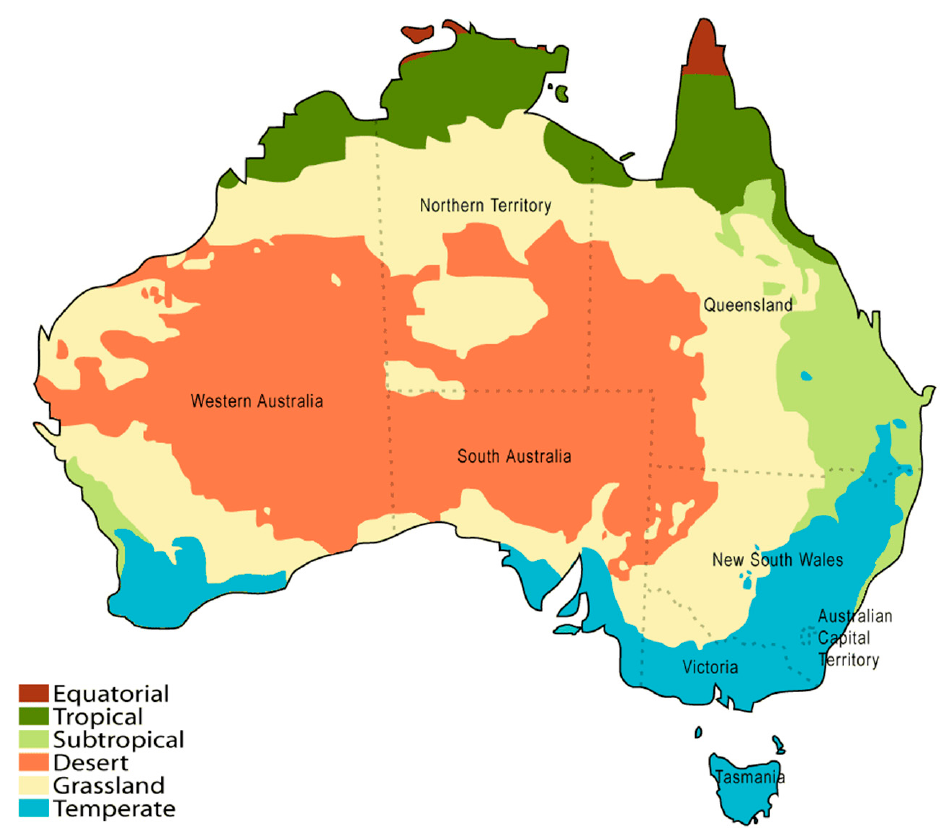
Figure 1. Australian climate map; image taken from https://en.wikipedia.org/wiki/Deserts_of_Australia (accessed on 15 January 2021).